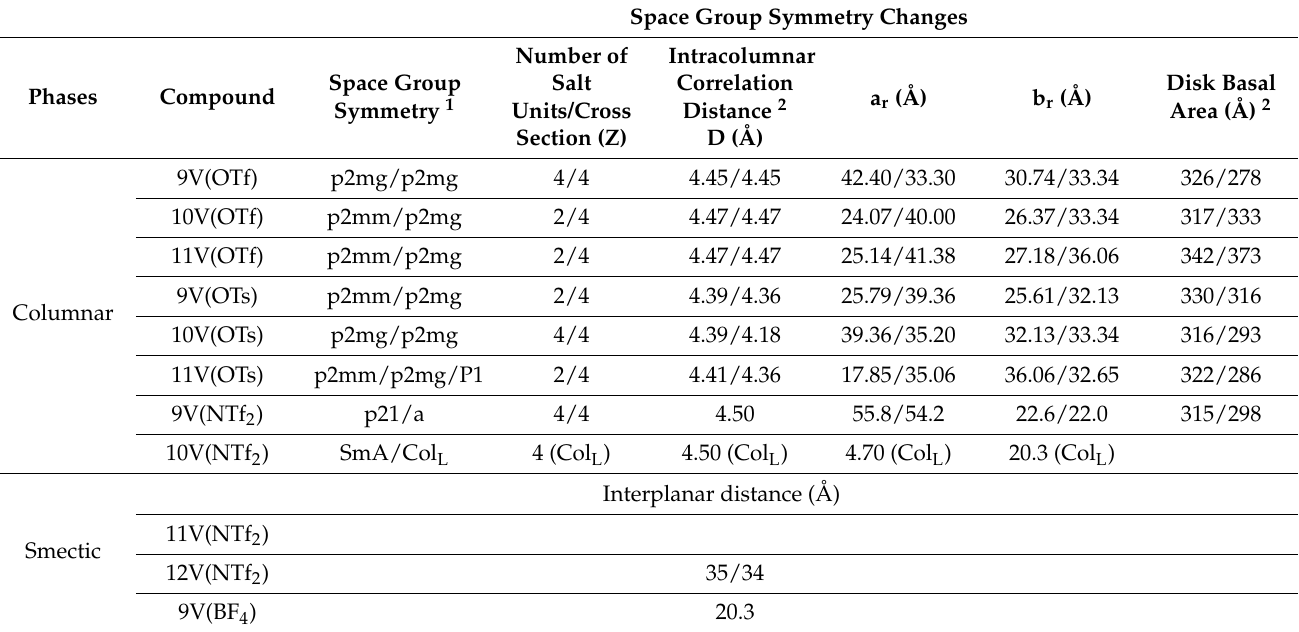
Table 4. Effect of temperature on the structural parameters of the mesophases upon the first disor- dered/ordered phase transition (on cooling from the IL state). Space Group Symmetry